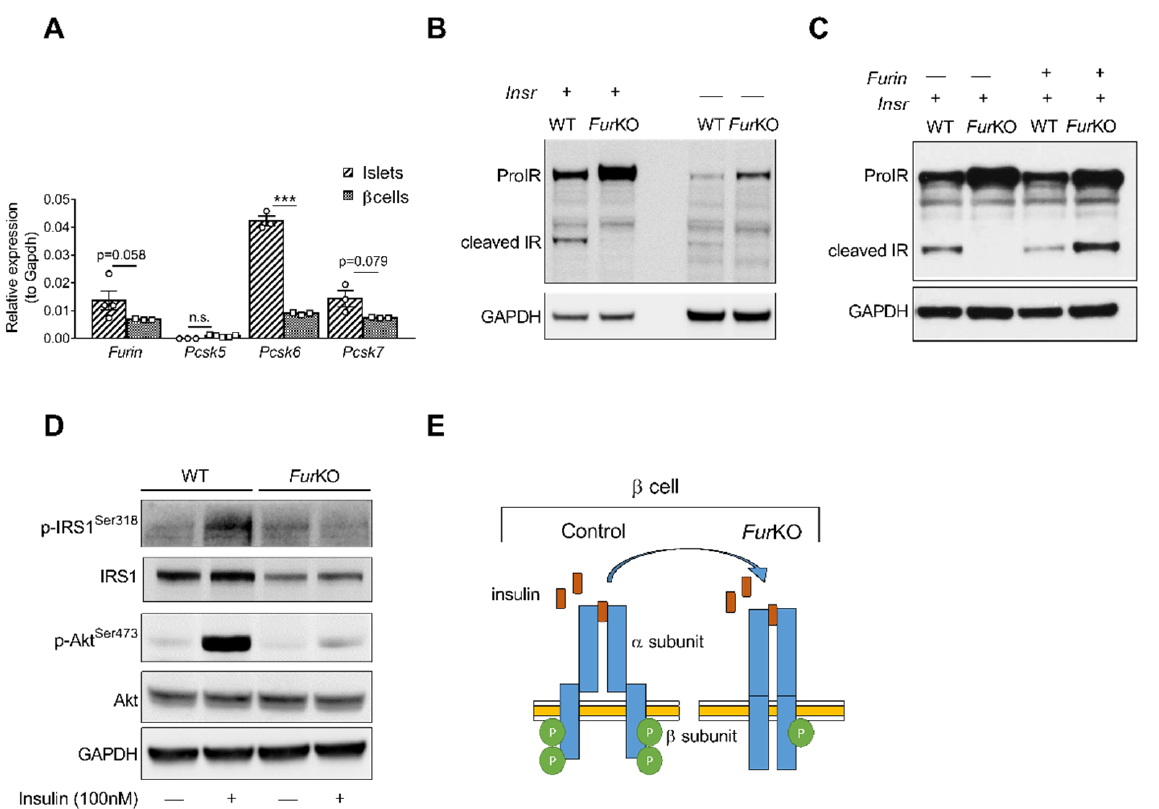
Figure 1. IR processing and signaling is severely affected in FurKO β cells. ( A ) Comparative RT-qPCR analysis of Furin , Pcsk5 , Pcsk6 , and Pcsk7 gene expression in the islets of Fur fl /fl mice ( n = 3–5 per genotype) and wild-type β TC3 cells. *** p < 0.001 determined by two-way ANOVA with Sidak’s multiple comparisons test. All the RT-qPCR data were normalized to Gapdh . ( B ) Western blot analysis of the IR protein level in whole-cell lysate of WT and Fur KO IR-transfected and non-transfected β TC3 cells. GAPDH was used as loading control. ( C ) Western blot analyses of IR protein levels in whole cell lysates from β TC3 cells transfected with Insr or co-transfected with Insr and Furin . GAPDH was used as loading control. ( D ) Western blot analysis of phosphorylated and total IRS1, and Akt in whole cell lysates from β TC3 cells treated with 100 nM insulin or vehicle for 5 min. GAPDH was used as loading control. ( E ) Schematic representation of a suggested mechanism of IR signaling in Fur KO β TC3 cells compared to a physiological